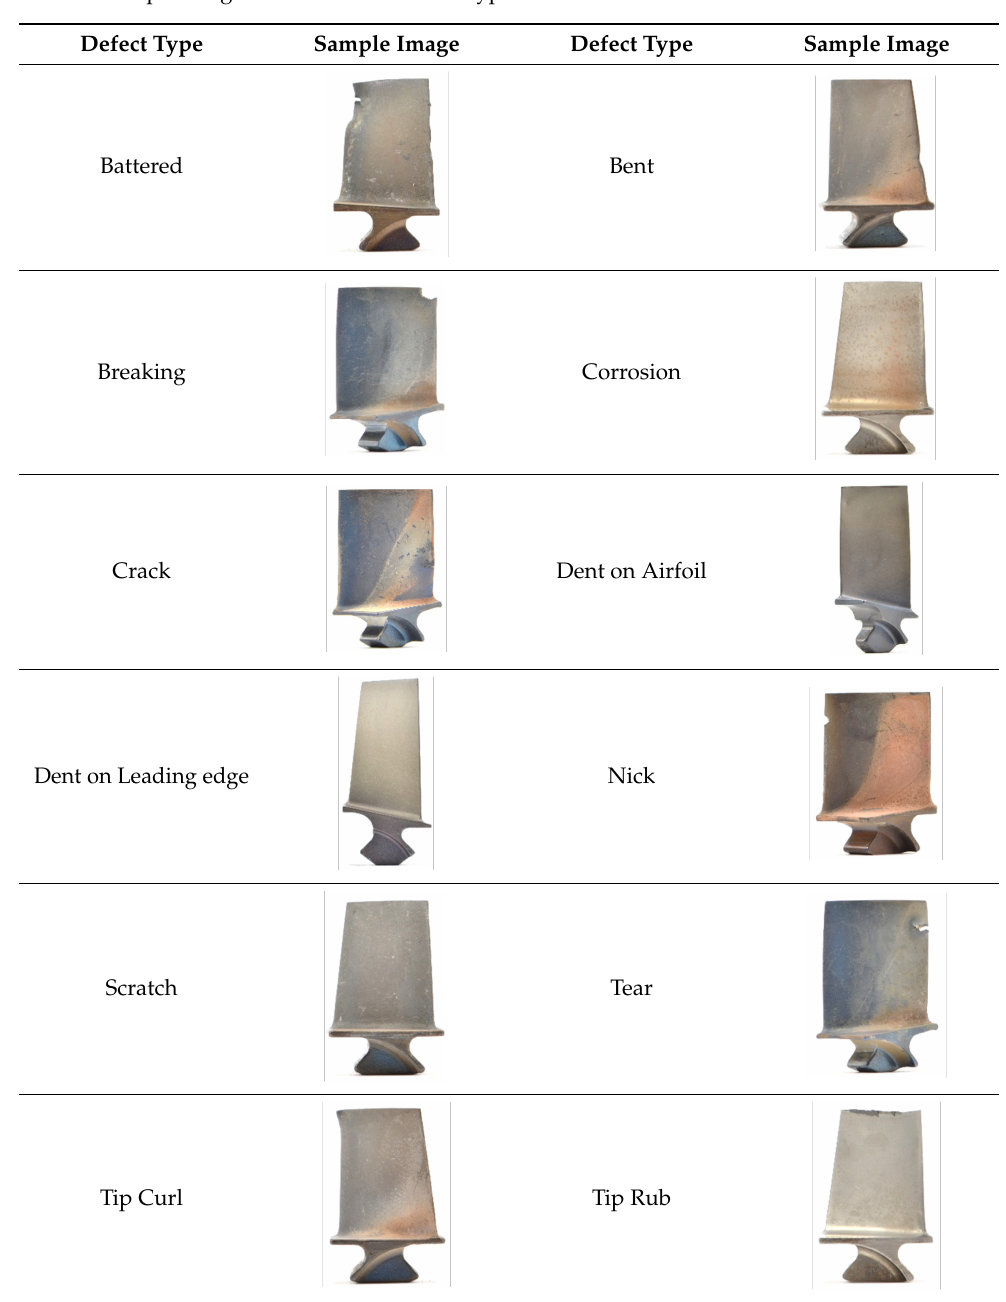
Table 2. Sample images for each blade defect